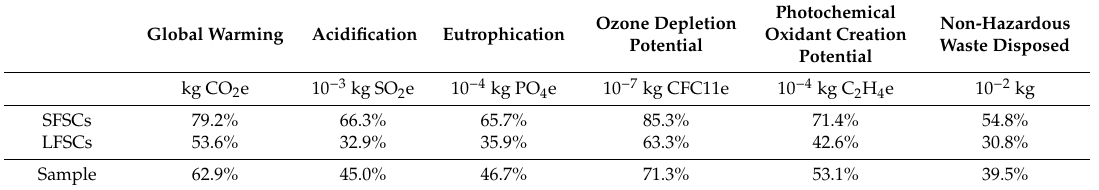
Table 12. Share of transport among eco-e ffi ciency LCA indicators for short and long supply chains. Global